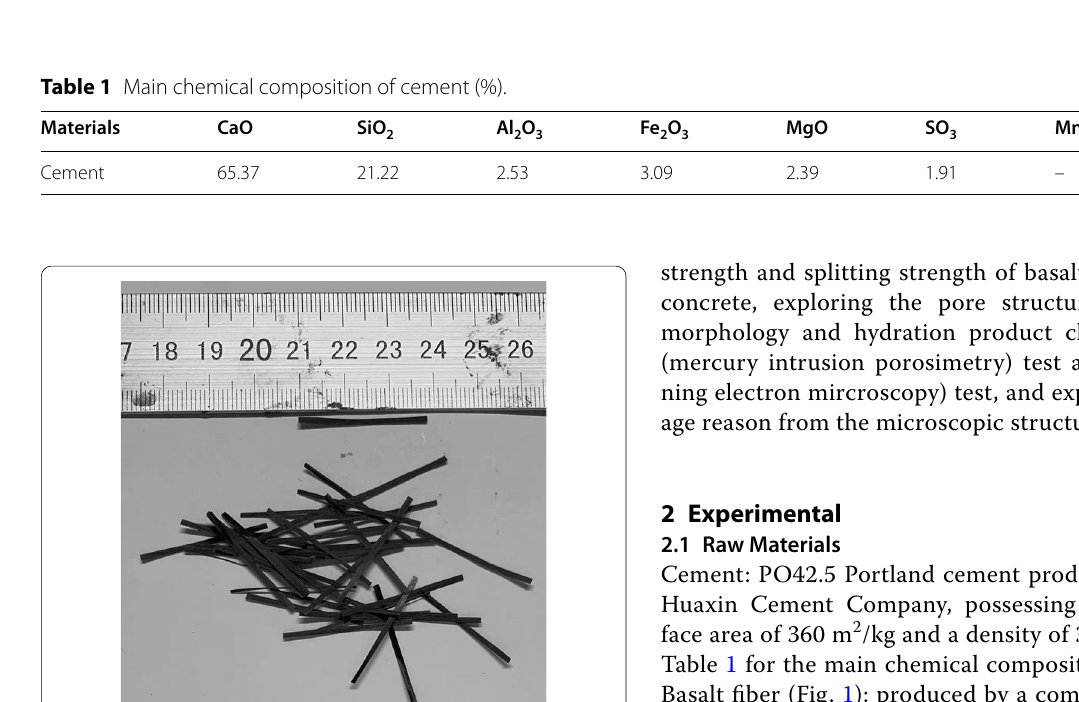
Table 1 for the main chemical composition of cement.) Basalt fiber (Fig. 1): produced by a company in Guang- dong (see Table 2 for basic performance and size of basalt fiber). Coarse aggregate: continuous graded granite gravel, particle size 5–20 mm. Fine aggregate: native river sand, particle size 0–4.75 mm. Water: laboratory tap water. Water reducing agent: naphtha- lene series efficient water reducing agent, whose water reduction rate is of more than 20%. A total of four experimental groups were set, with 30 specimens in each group. Group C was pure cement concrete, and BFRC1, BFRC2, BFRC3 was basalt fiber reinforced con- crete (basalt fiber content by volume was 0.1%, 0.2%, 0.3%, respectively). Concrete design strength grade is C40 (see Table 3 for specific mix ratio).